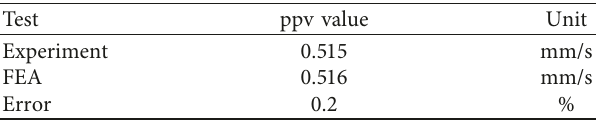
Table 4: Comparison of ppv values obtained from FEA and ex- perimental